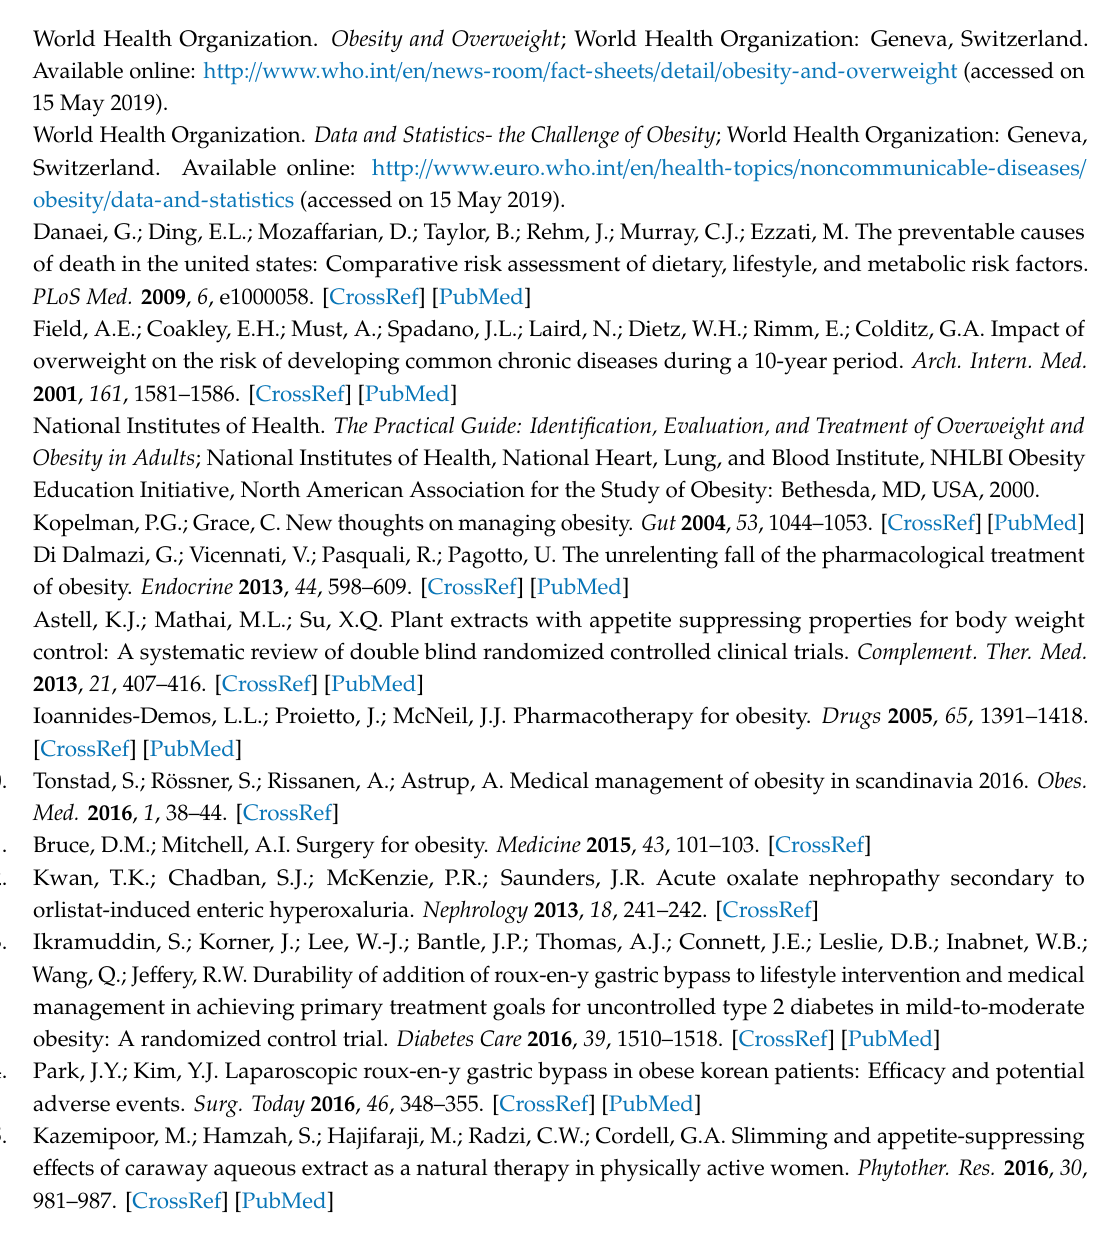
Table S4: Composition of the bioactive phytochemicals in the included studies, Table S5: Nutritional regimens, Table S6: Primary outcomes, Table S7. SIGN checklist for randomized controlled trials